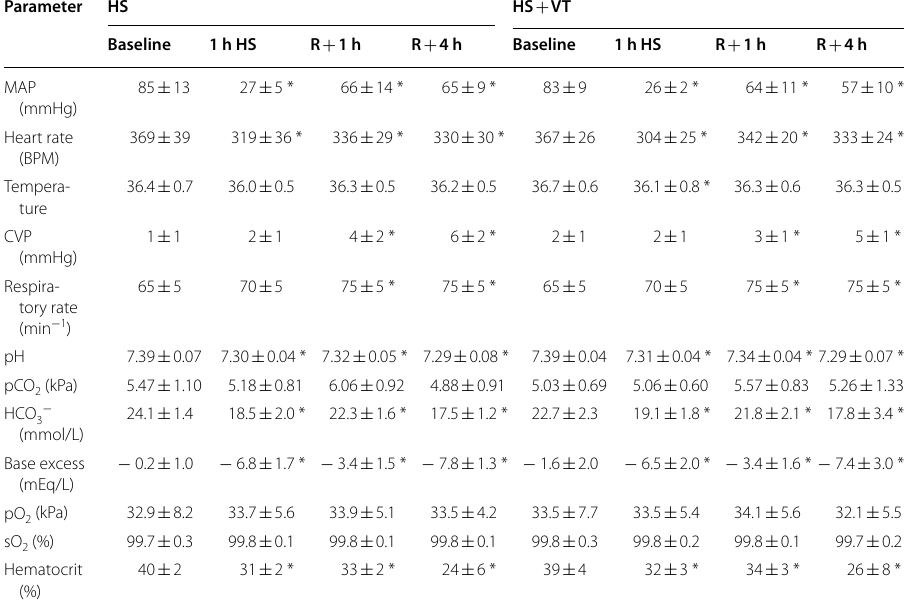
Data are presented as mean SD. * P < 0.05 compared to the baseline value of the corresponding group. No differences ± were found between vasculotide (VT) and untreated HS rats. HS; hemorrhagic shock group, HS group treated with vasculotide, 1 h HS; values measured at 1 h following start blood withdrawal, R at 1 h following start of fluid resuscitation, R 4 h; values measured at 4 h following of start fluid resuscitation, MAP; mean + arterial pressure, CVP; central venous